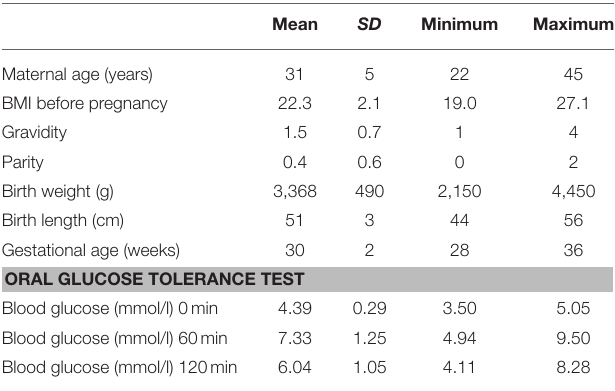
TABLE 1 | Descriptives of the n = 52 included